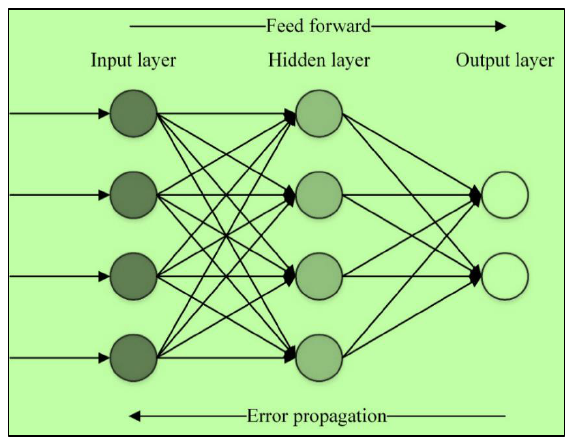
Figure 1. A typical structure of Artificial Neural Networks